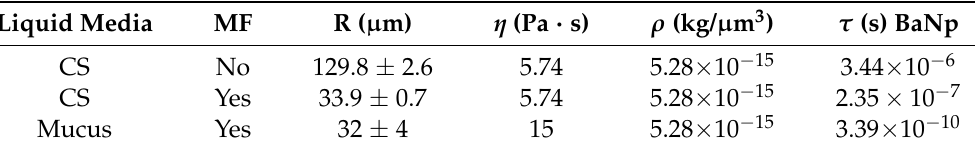
Table 4. Characteristic time, τ of BaNps in corn syrup (CS) and mucus. All τ s are 10 − 6 s or less and hence have little effect on v ter . Characteristic time τ was calculated by Equations (7), (9), (10), and (18). Uncertainty in R was propagated from errors in r m and r n listed in Table 1, by the method of Section 2.8. The propagated uncertainties in τ were